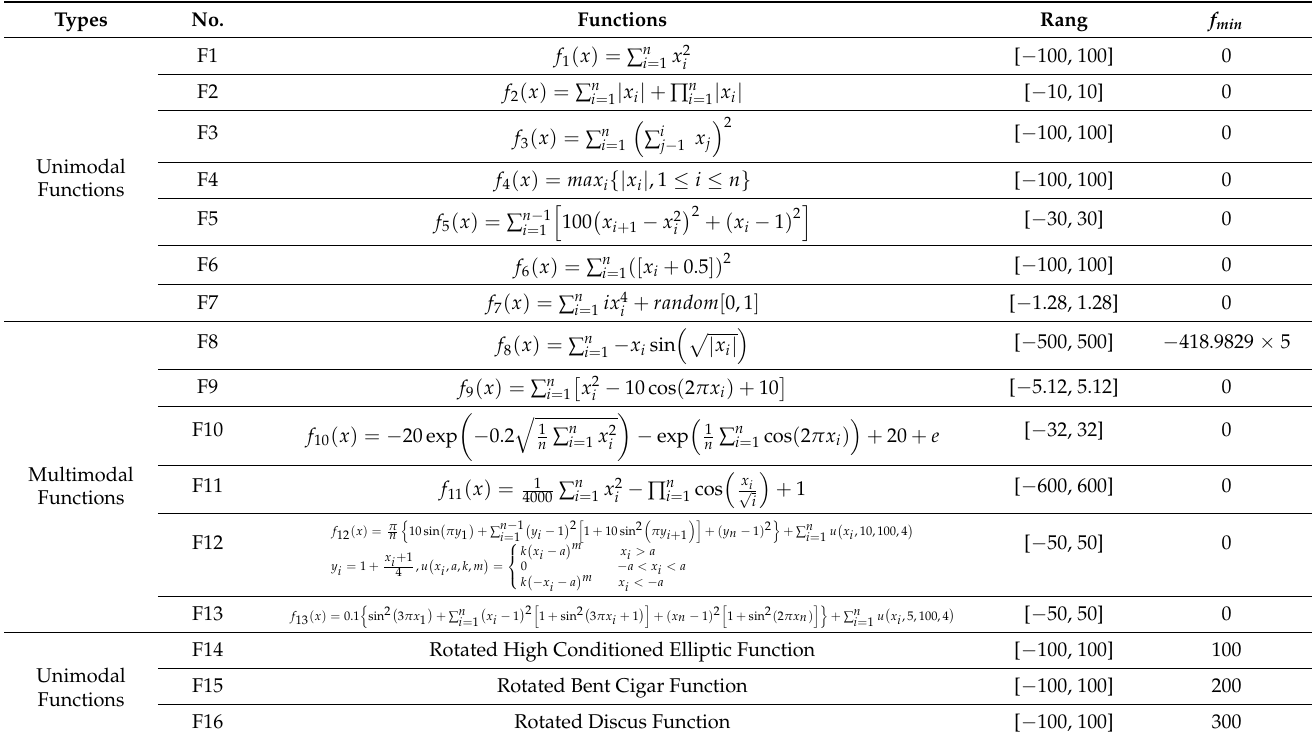
Table A1. Details of the selected 35 benchmark